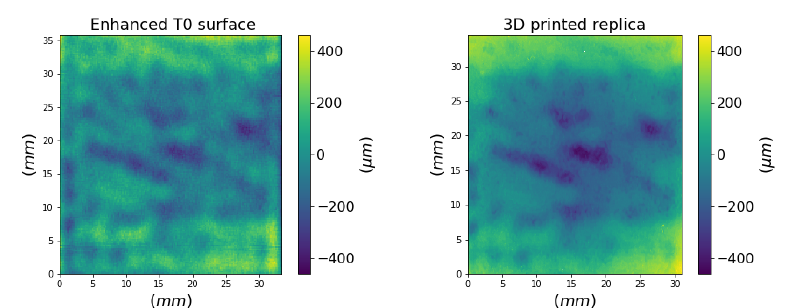
Figure 5. Surface height map of the enhanced surface T0 and its 3D printed